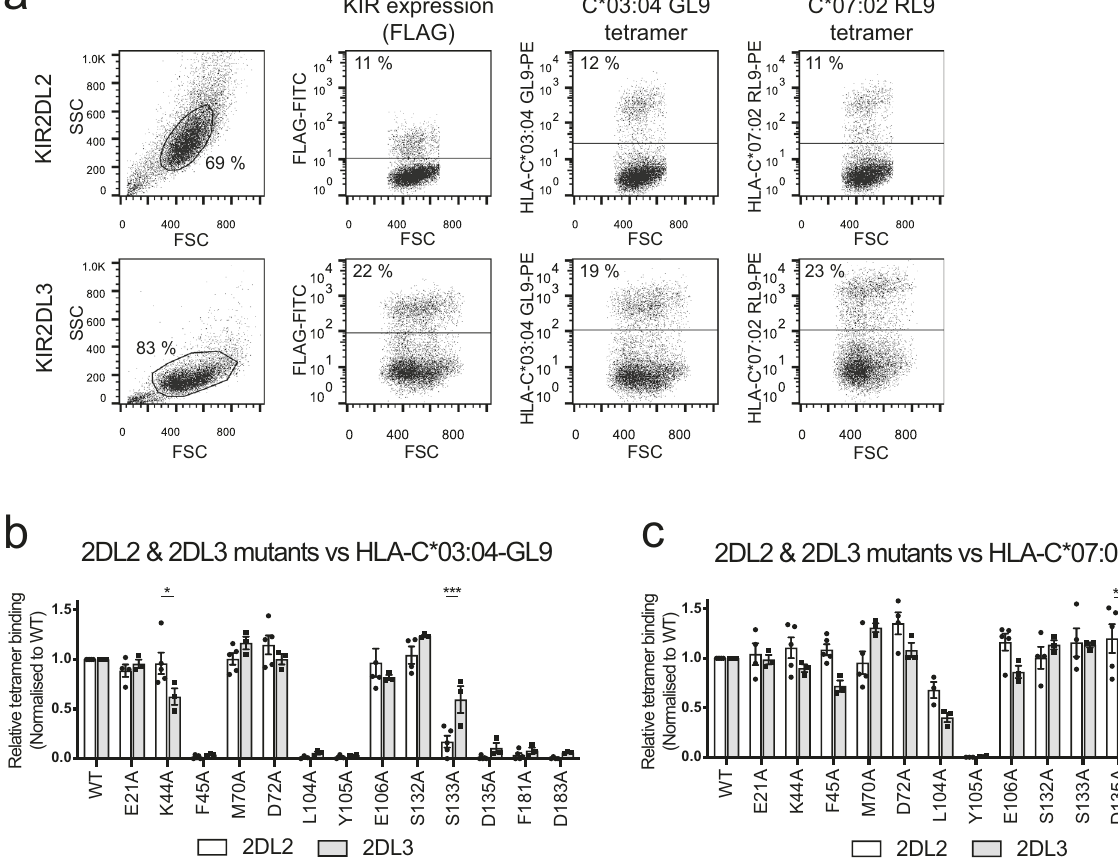
Fig. 3 Mapping the interaction between KIR2DL2/2DL3 to HLA-C*03:04-GL9 and C*07:02-RL9. 293T cells were transfected with plasmids encoding either wild-type or mutant FLAG-tagged KIR2DL2 and KIR2DL3 and then stained with a FLAG-speci fi c mAb or HLA-C*03:04-GL9 and HLA-C*07:02-RL9 tetramers. Representative dot plots showing staining to cells expressing wild-type KIR2DL2 and KIR2LD3 ( a ). Relative binding of wild-type (WT) KIR2DL2 and KIR2DL3 transfected 293T cells and their respective alanine mutants to phycoerythrin-conjugated tetramers of HLA-C*03:04-GL9 ( b ) and HLA- C*07:02-RL9 ( c ). Transfected cells were stained for FLAG as a marker of KIR2DL expression and separately stained with HLA tetramers. Percentage tetramer + was normalised to percentage FLAG + to account for differing KIR2DL transfection ef fi ciency between mutants. The data represent a minimum of n = 3 independent experiments; bar line = mean, error bars = standard error of the mean (SEM); individual data points = circles (2DL2) or squares (2DL3). For each independent replicate, relative tetramer staining was normalised to staining of WT KIR2DL. Statistically signi fi cant differences in ligand recognition between corresponding mutants of KIR2DL2 and KIR2DL3 as measured by Two-way ANOVA Š idák ’ s multiple comparison test are highlighted. 2DL2 ( n = 5) vs. 2DL3 ( n = 3) binding to C*03:04-GL9 K44A: * P = 0.0127; 2DL2 ( n = 5) vs. 2DL3 ( n = 3) binding to C*03:04-GL9 S133A: *** P = 0.0005; 2DL2 ( n = 5) vs. 2DL3 ( n = 3) binding to C*07-02-GL9 D135A: *** P